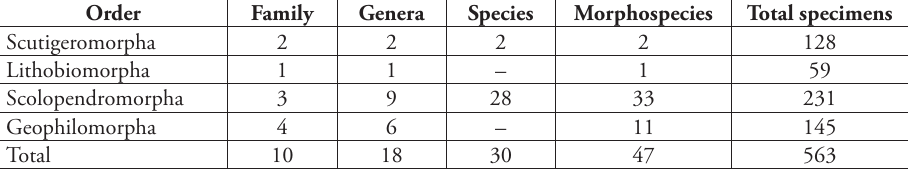
Table 1. Number of records of centipedes from Brazilian caves considering family, genera, species, and morphospecies.